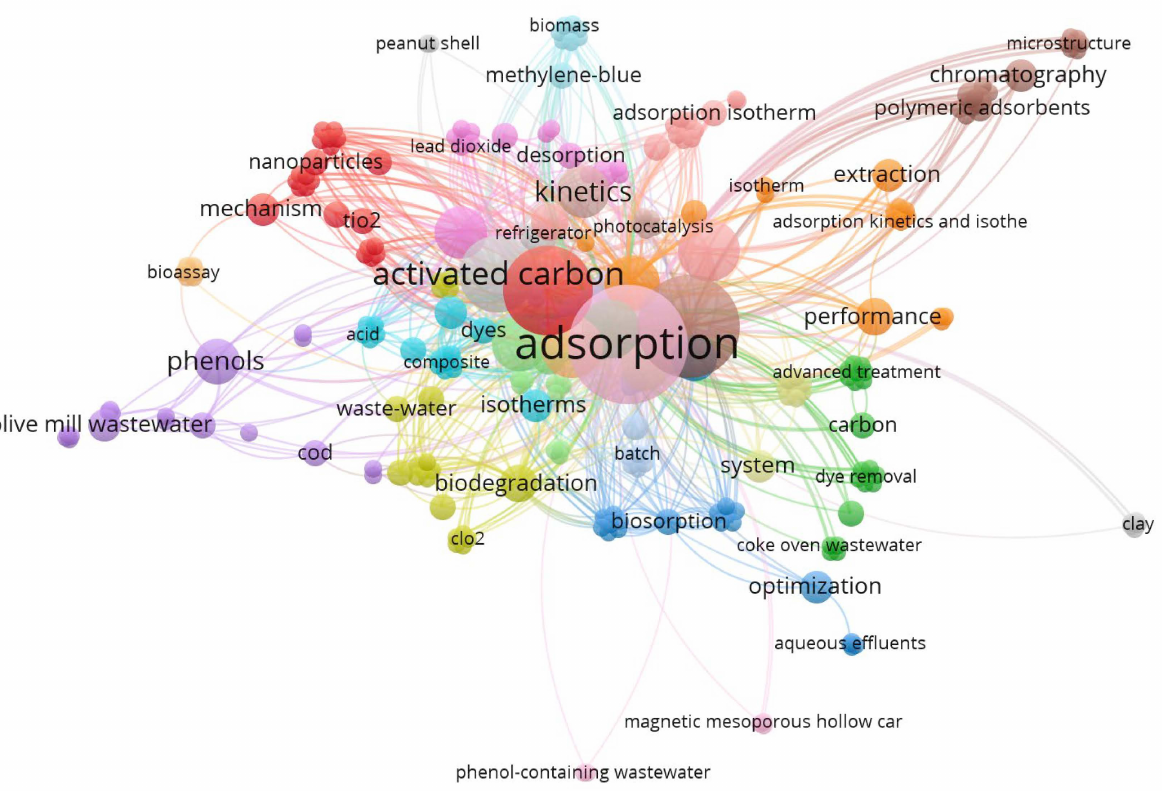
Figure 1. Bibliometric technique analysis for the search items “wastewater” comprising “Phenol” AND Treatment AND “Adsorption” conducted via “VOSviewer